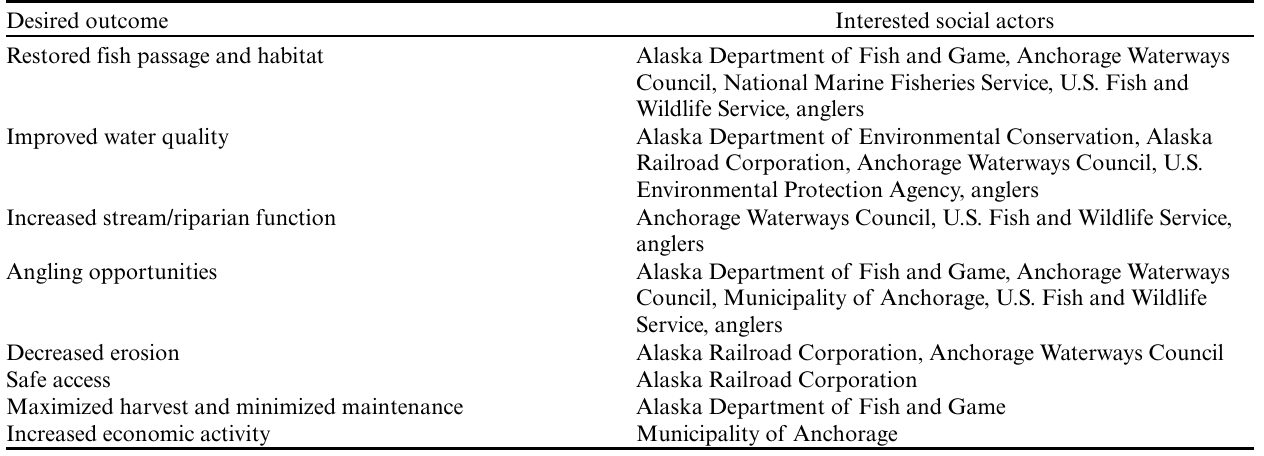
Table 1. Cross-scale linkages of user groups, the resource, public infrastructure providers, and rules and